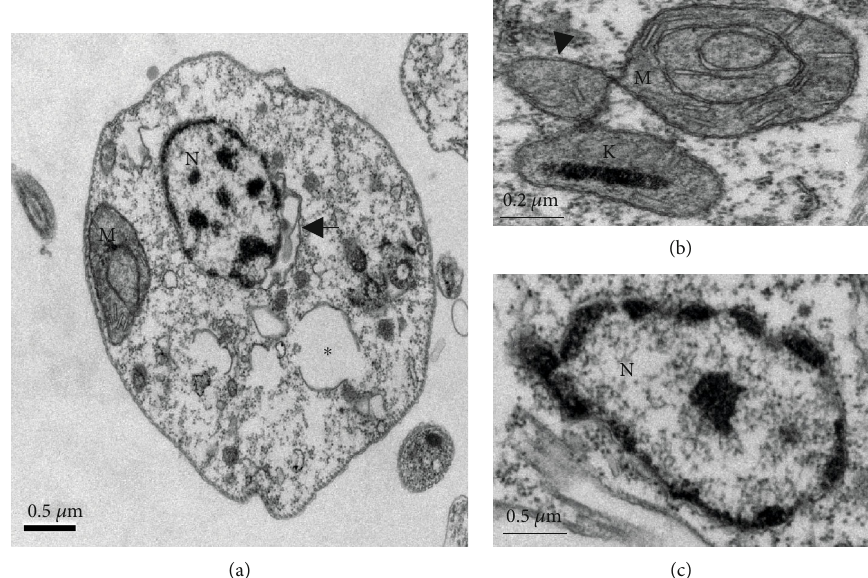
Figure 5: Ultrastructure of promastigote forms of L. ( L. ) infantum treated with EC of miltefosine during 24h: (a) parasites treated with 50 miltefosine lost its fusiform morphology; areas of cytoplasm degradation ( ∗ ) and detachment of nuclear membrane were observed (black arrow) ( × 30K); (b) miltefosine altered the morphology of the kDNA (k)-mitochondria (M) complex that presented to be fragmented and with blebs (arrowhead) ( × 80K); (c) nucleus (N) with condensed chromatin in parasites treated with miltefosine ( ×